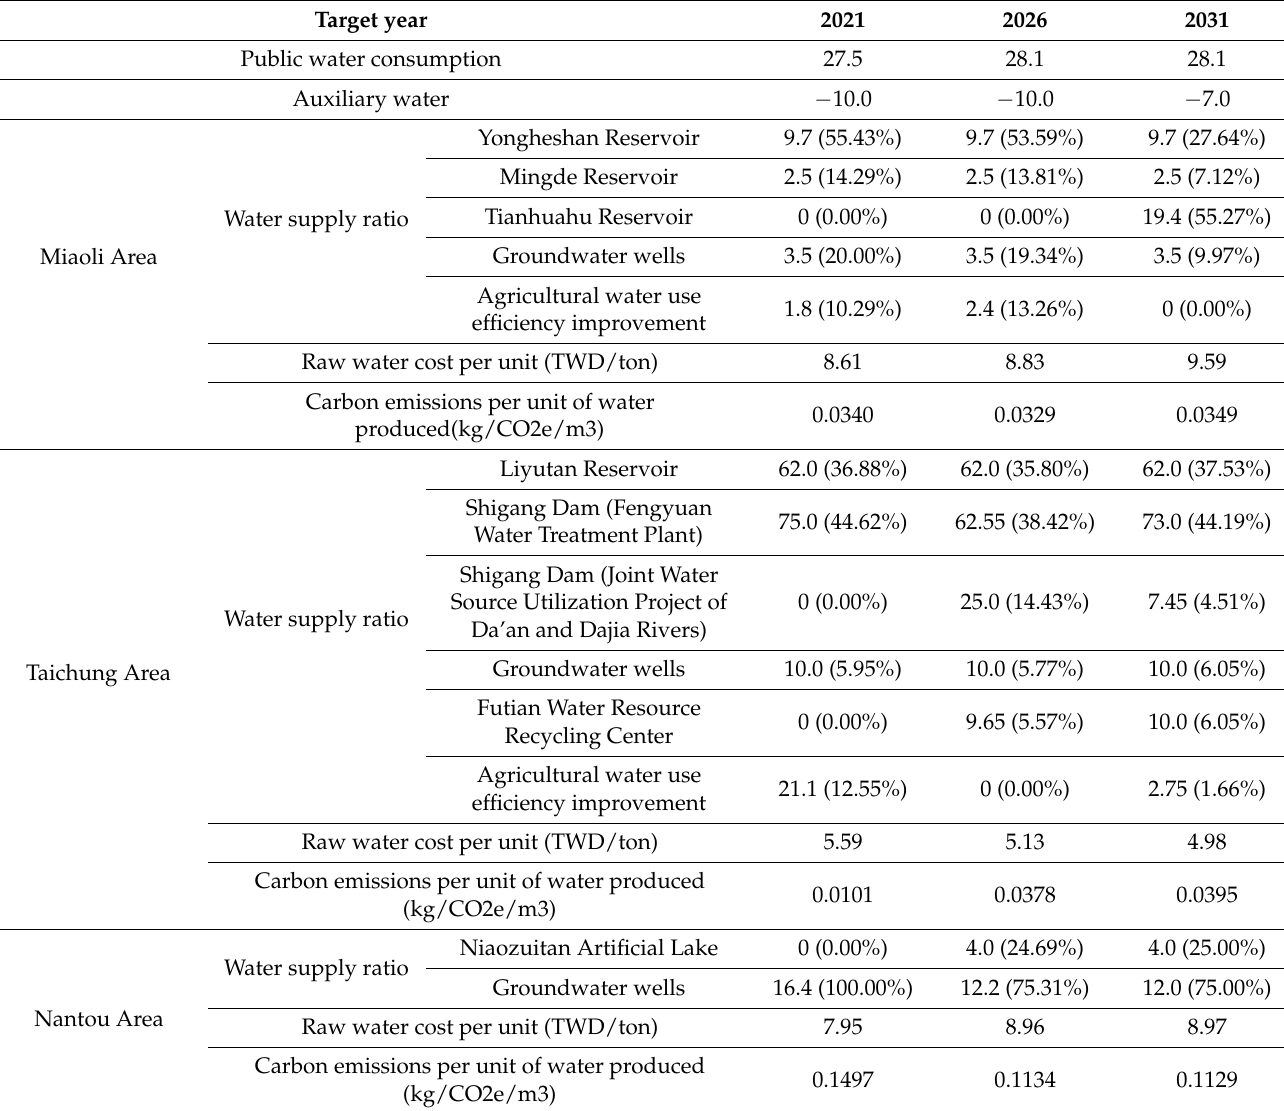
Table 6. Water Supply Portfolio for Water Supply Security in Central Taiwan under a Dry